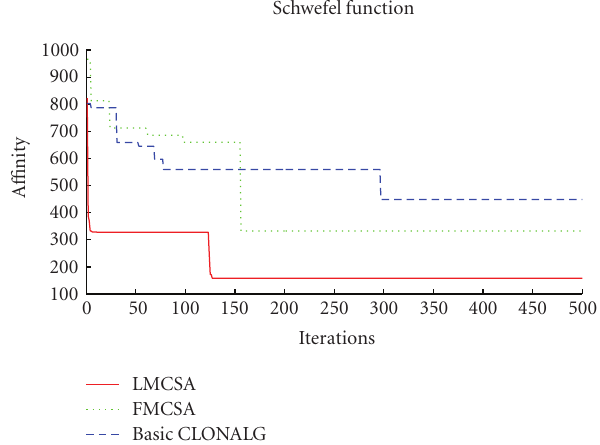
Figure 12: Convergent performances on generalized Schwefel’s Problem 2 . 26 ( f 10).